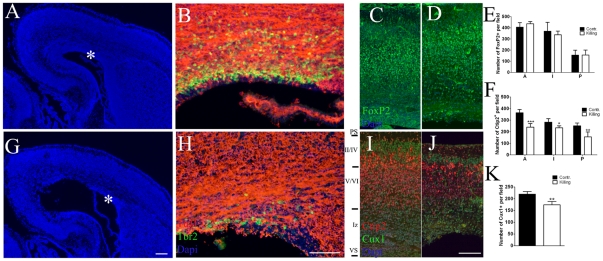
The selective killing of E12.7/E13.2 AspM+ cells altered the forebrain cortical organization.Panels A, G show low magnification of E18.5 coronal sections from a control –i.e. embryos lacking the Nestin-GFPflox-TK allele (A) and AspM-CreERT2/Nestin-GFPflox-TK (G) forebrains both treated with Tam and GCV (n = 3 for each group). Asterisks indicate the VZ/SVZ regions assayed for Tbr2 and TuJ1 detection. Control mice displayed a distinct layer of Tbr2+ BP cells that was clustered in the outer VZ (B). In contrast, double transgenic mice treated with GCV displayed a severe reduction of these cells (H). Double transgenic mice show a preserved cortical layer organization, although upper layers appeared thinner than normal. Coronal sections from control (C) and double transgenic (D) brains stained with Foxp2, which label deep layer neurons, show the preservation of deep cortical layer. Cells were count at three different levels along the anterior-posterior axes and the mean number of FoxP2+ cells (± S.D.) is plotted on panel E. Sections were also stained for Ctip2 (layer V) and Cux1 (layer II–IV) in control (I) and double transgenic (J) brains. Cell counts are provided in panels F and K, and show a significant reduction of upper cortical neurons in AspM-CreERT2/Nestin-GFPflox-TK mice. VS, ventricular surface, Iz intermediate zone, PS pial surface. * p<0.05, ** p<0.01, *** p<0.001, t-student. Scale bar 100 µm.